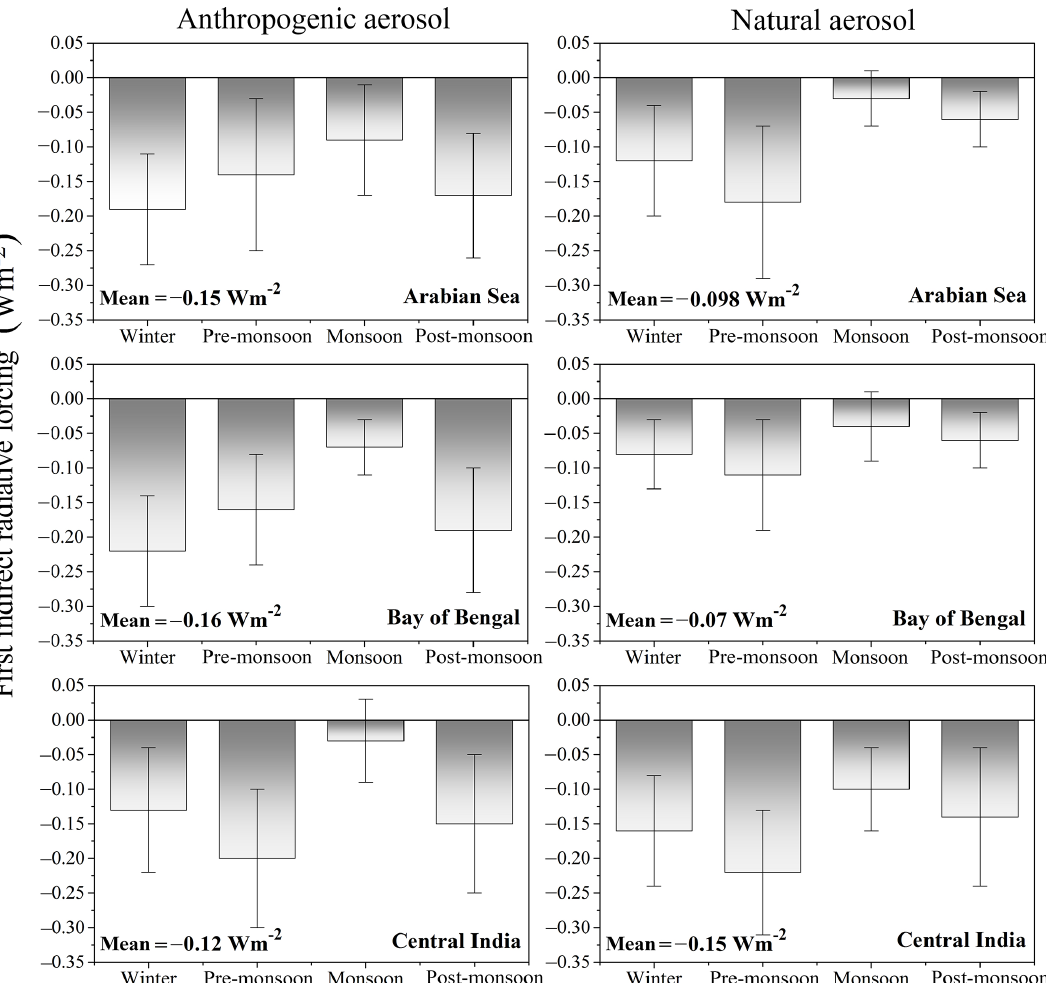
Figure 4. Seasonal variability of 6-year averaged RF aci obtained using the nonlinear fit for all three regions for both anthropogenic and natural aerosols along with mean